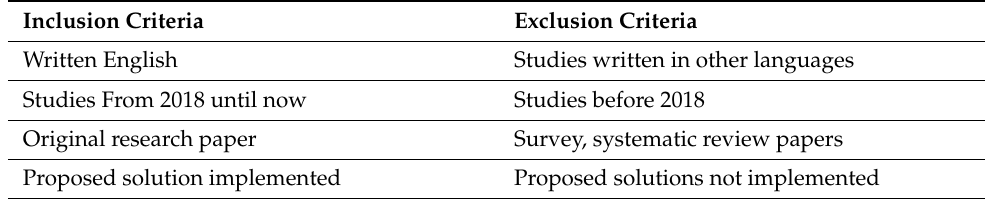
Table 3. Criteria